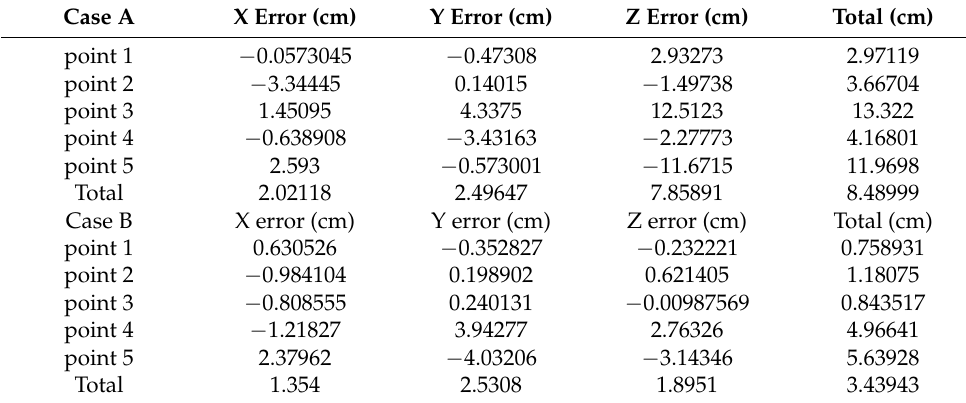
Figure 7. Dense point cloud: ( a ) case A, ( b ) case B. Table 1. GCPs x,y,z and total RMSE in case A and case